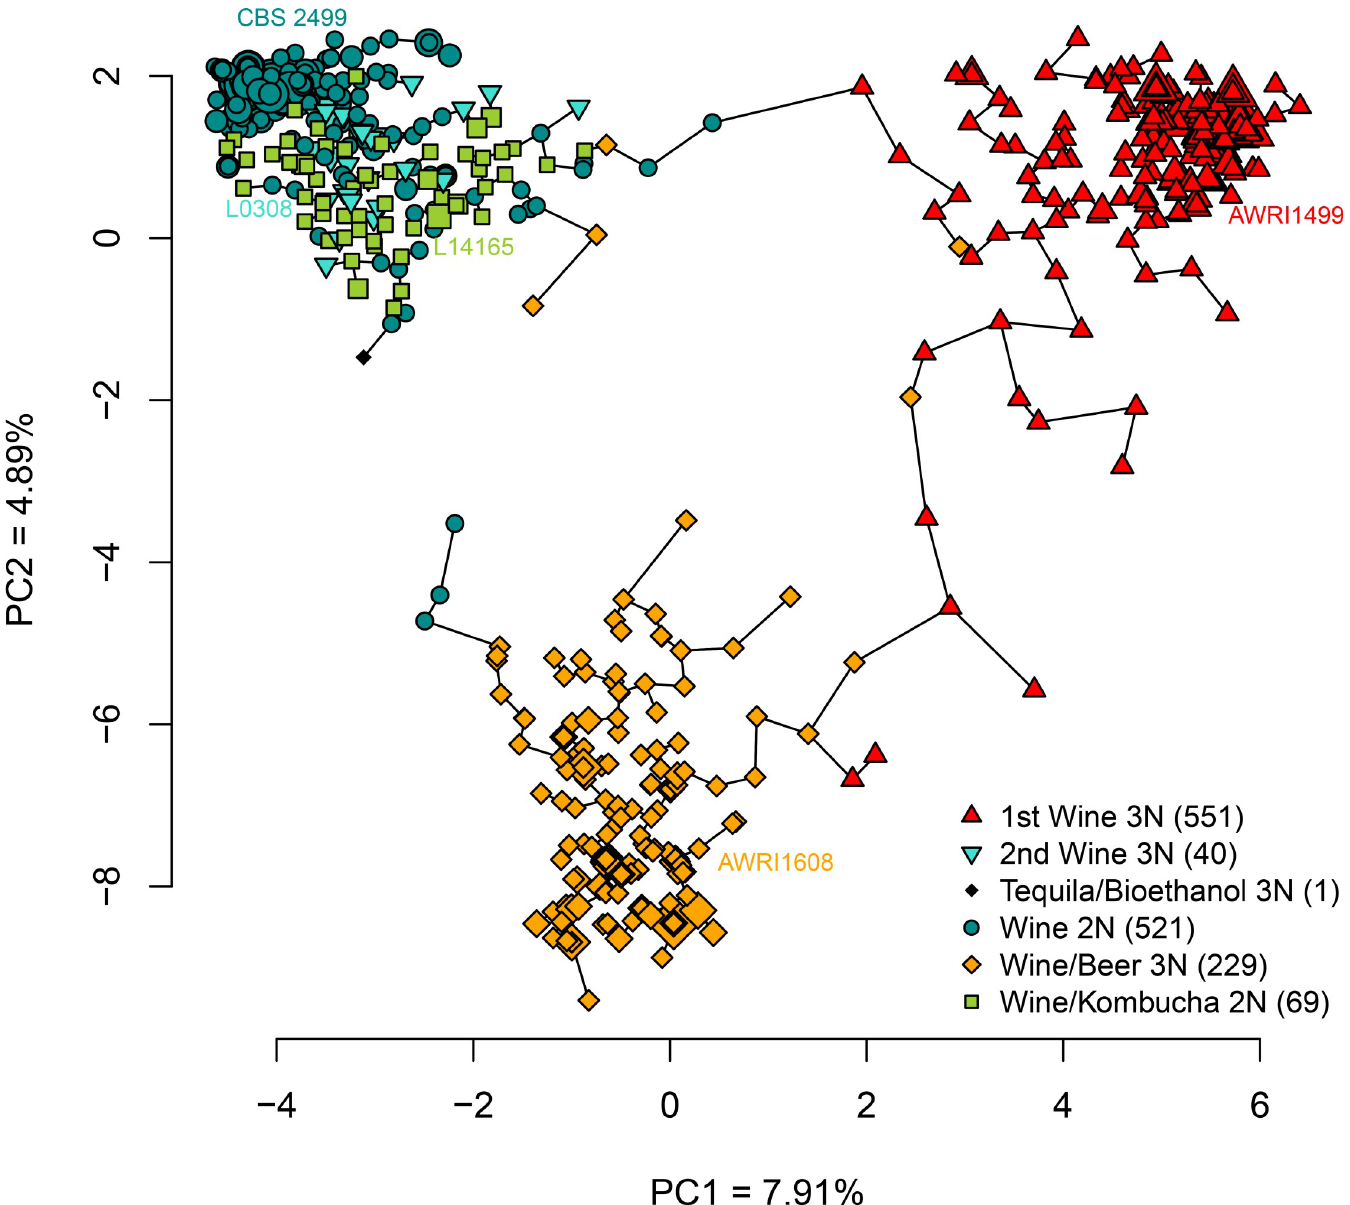
Fig 1. Minimum spanning tree of wine Brettanomyces bruxellensis isolates based on genetic distances. 1411 strains were genotyped using 12 microsatellite markers. A PCA was performed using the R ade4 package. Only the two first axes (principal component, PC1 and PC2) were represented. The connection network and minimum spanning tree was built using the chooseCN function from R adegenet package. For genetically identical isolates (aka ‘clones’), the size of the points is log10 proportional to the number of isolates.